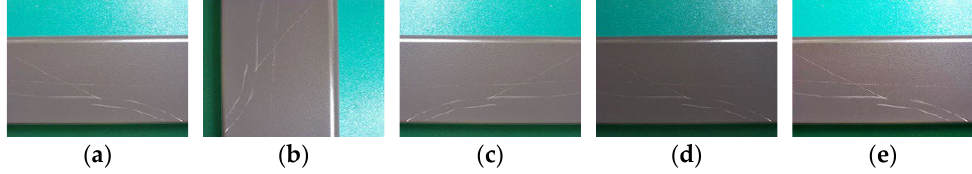
Figure 2. Data augmentation. ( a ) Original image; ( b ) Rotation; ( c ) Flip; ( d ) Brightness transformation; ( e ) Contrast transformation.